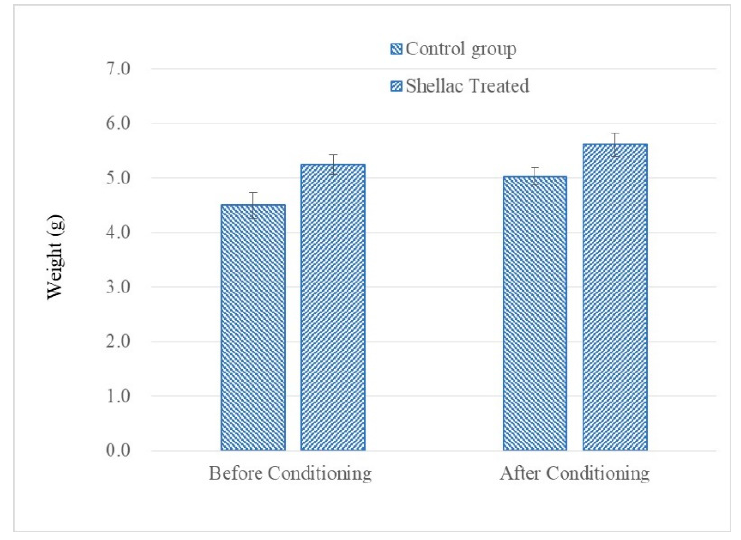
Figure 2. Weights of the specimens before and after conditioning.